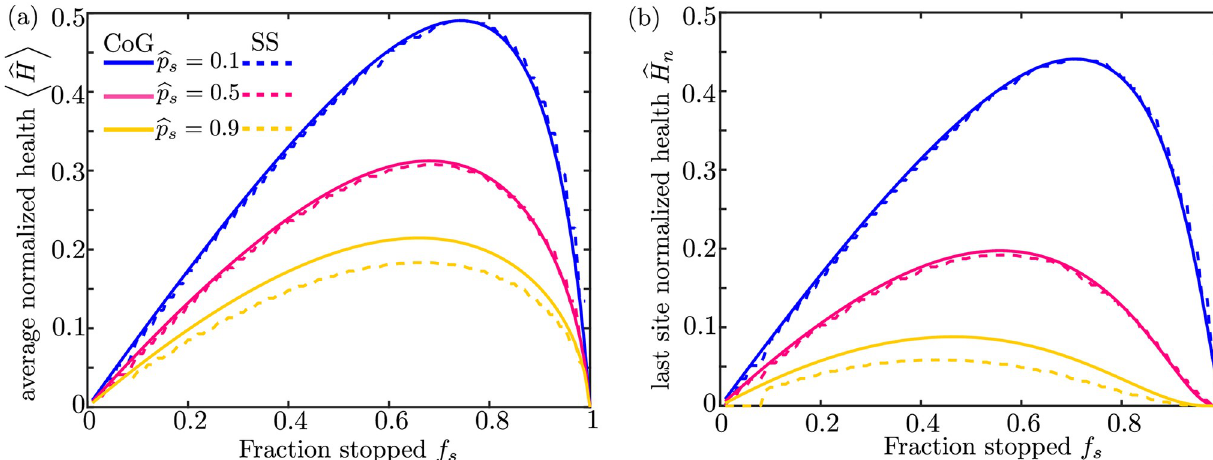
Fig 3. Comparison of mitochondrial maintenance models for matched parameter values. (a) Steady-state normalized mitochondrial health averaged over all demand regions is computed with the CoG model (solid lines) and the SS model (dashed lines) as a function of the fraction of stopped mitochondria ( f ) for three different values of the effective protein stopping probability ^ p s distal demand site, for both models. All values are computed with M = 1500, ^ k